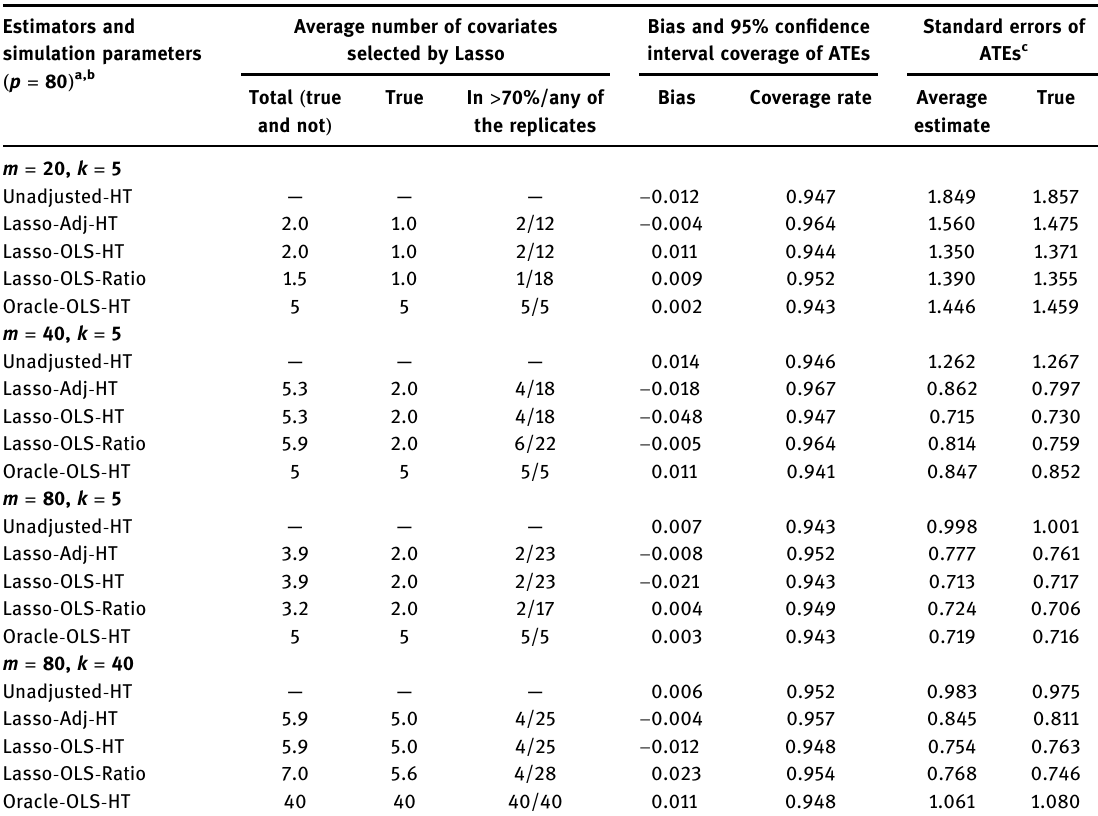
Table B1: Simulation results using the two - stage estimation procedures for ρ = 0.05 Estimators